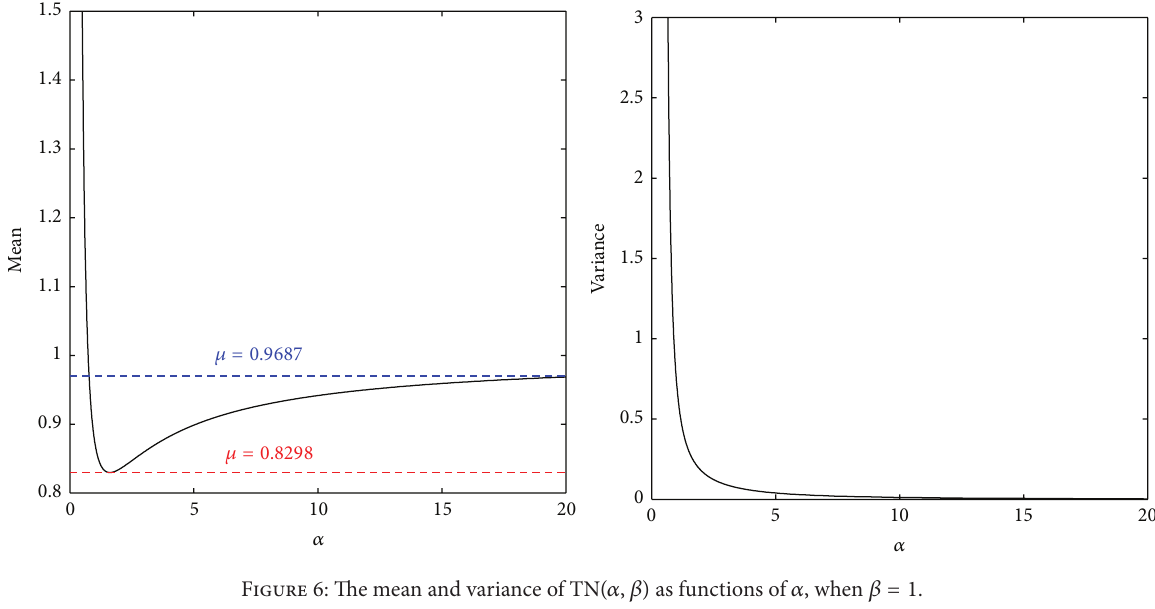
Figure 6: The mean and variance of TN (𝛼,𝛽) as functions of 𝛼 , when 𝛽 = 1 .